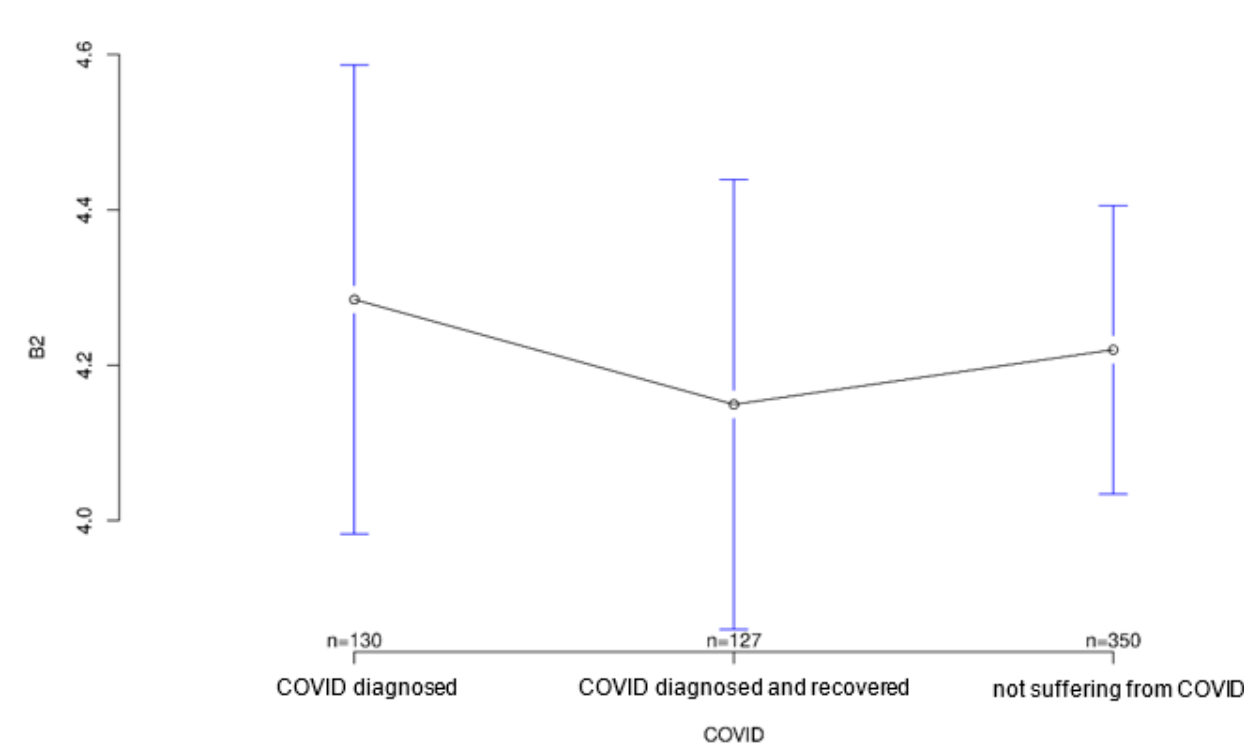
Figure 4. Average agreement with statement 2 of the COVID-specific questionnaire: “Multiple sensors on the body could make a person appear older or more ill than they are.” The y -axis shows the mean result of participants choice on the Likert scale.